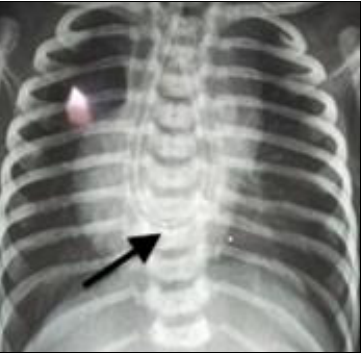
Figure 1: Infant feeding tube coiling at T8 (Arrow)